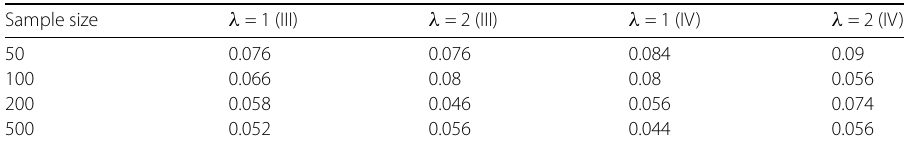
Table 5 Empirical sizes Sample size